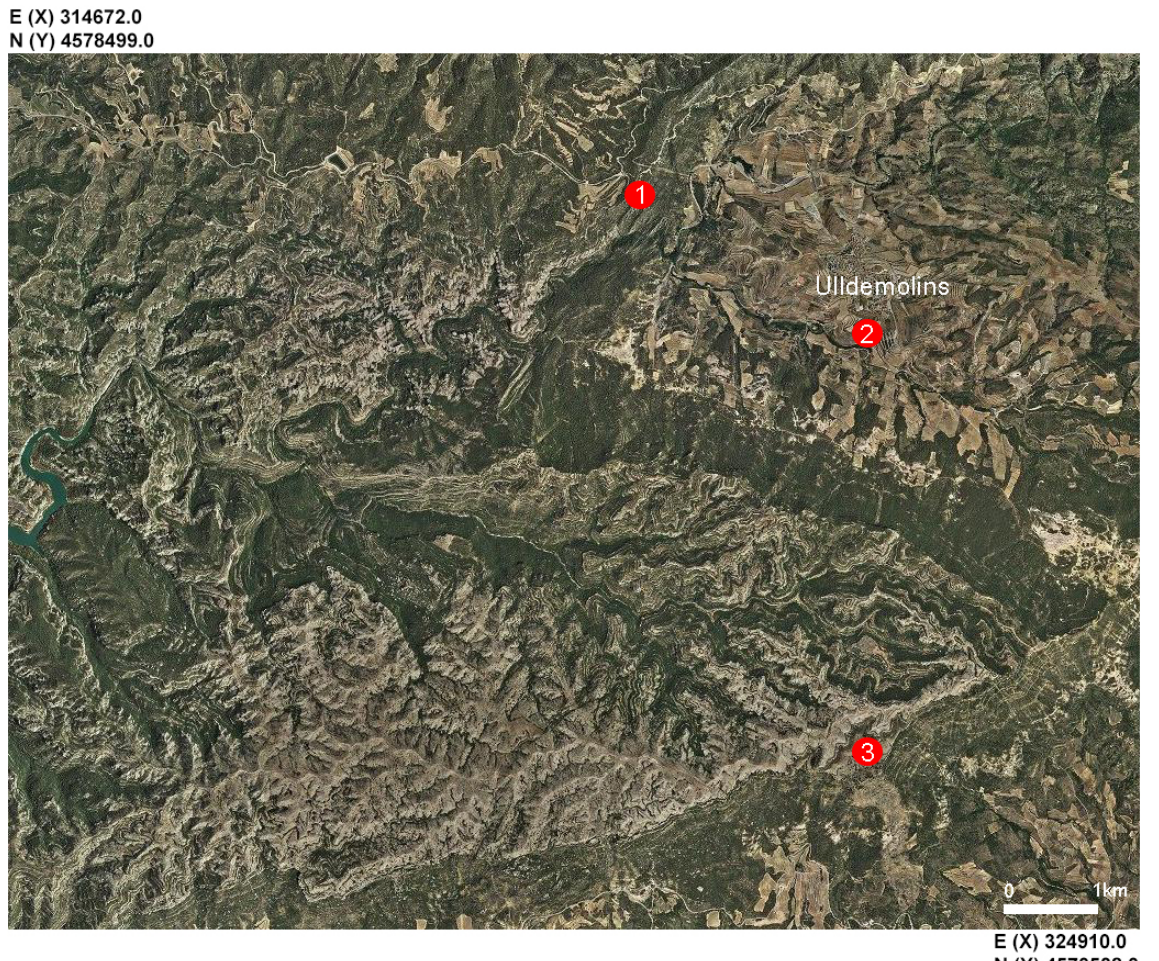
Figure 3. Itinerary of The Silica Road trip: 1-The Montsant Overlook; 2-Ulldemolins Cherts; 3- The Ulldemolins Complex. (Orthophoto, 1:25,000 - UTM 31N (ETRS 89), modified from ICGC (2016b))